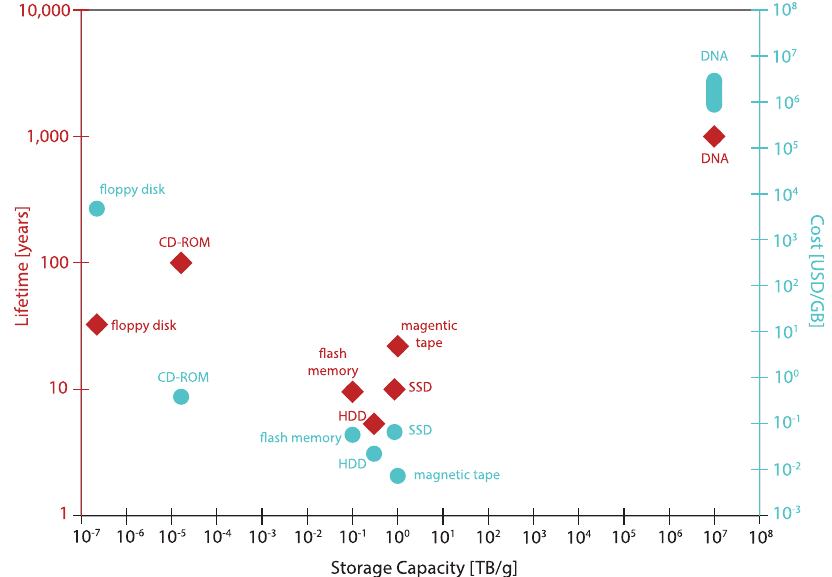
Fig. 2 Lifetime, current storage capacity, and costs of various storage systems. Estimates for mainstream media were made with consumer pricing data. Note that (1) these costs are an estimation at the point at which this work was written and (2) that the basis for calculation is not perfectly aligned, as to date DNA data storage cannot be purchased as a routine commercial electronic storage medium and read/write infrastructure has not been scaled 10,31 .